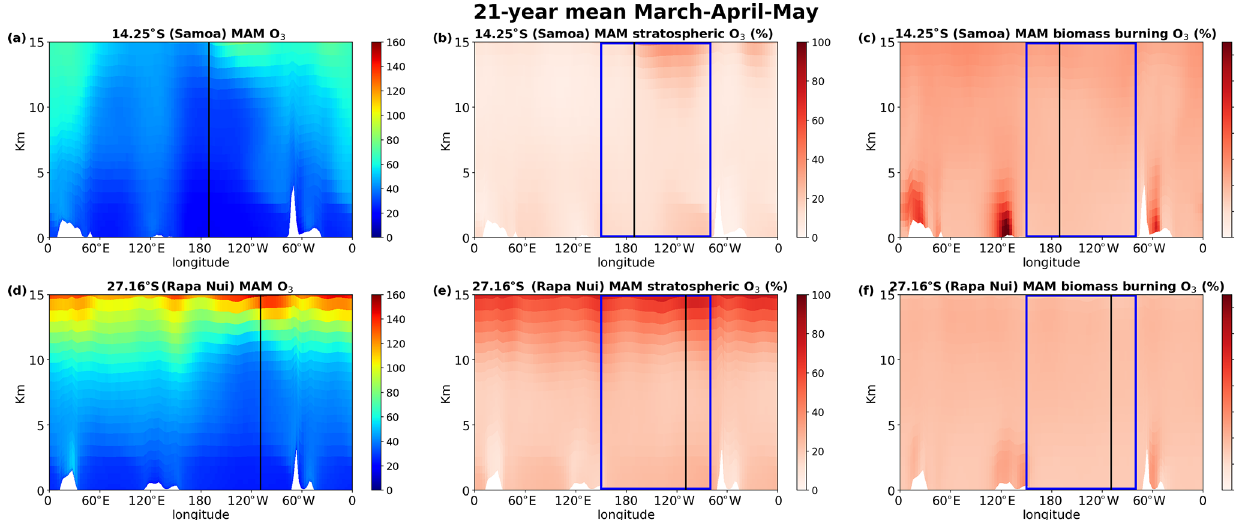
Figure 10. As in Fig. 10 but for Southern Hemisphere fall (March–April–May). Note that the third column scales up to 15%.